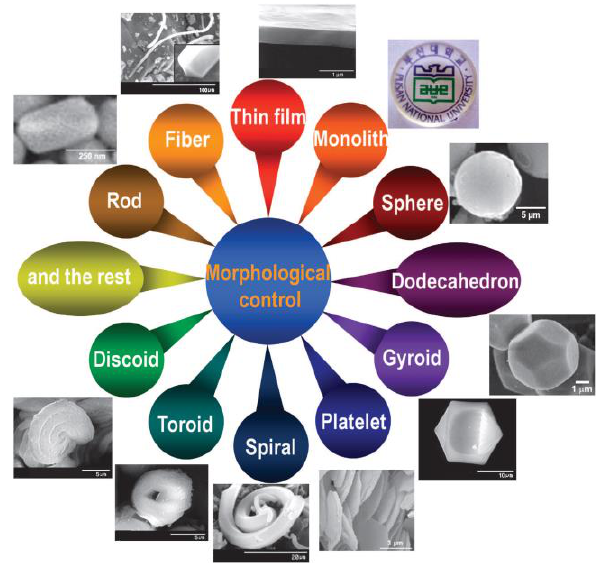
Figure 2. SEM images of PMOs with different morphologies ( a – i ). Reprinted from Reference [80]; copyright (2006) with permission from